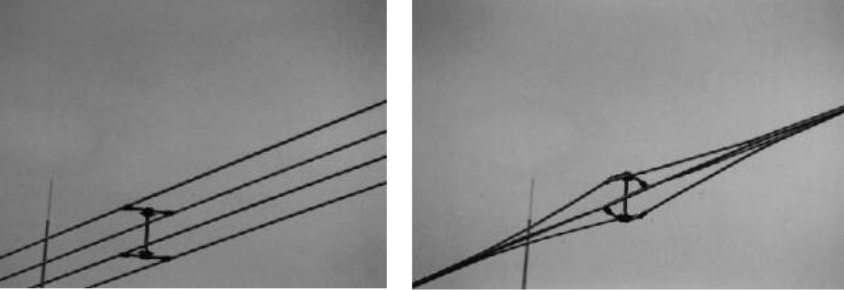
Figure 5. Static tension: ( a ) Graph of beam force and displacement values of the support structures [5], ( b ) Tie wires before and during a short circuit [6].